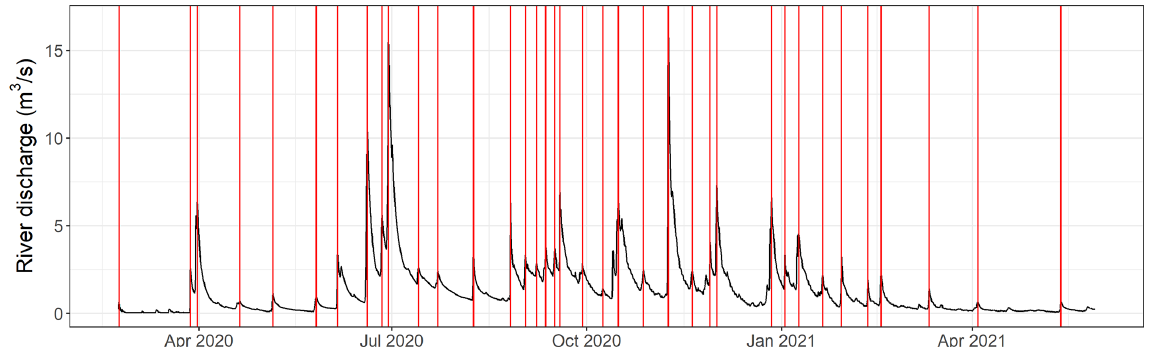
Figure 4. Hydrograph and flow peaks selected to calculate the time since the last peak and the peak height associated with each transmission loss